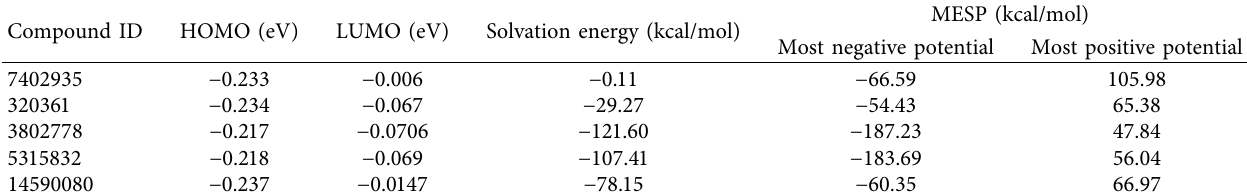
Table 3: HOMO, LUMO, solvation energy, and MESP of top hit homeopathy compounds. Compound ID HOMO